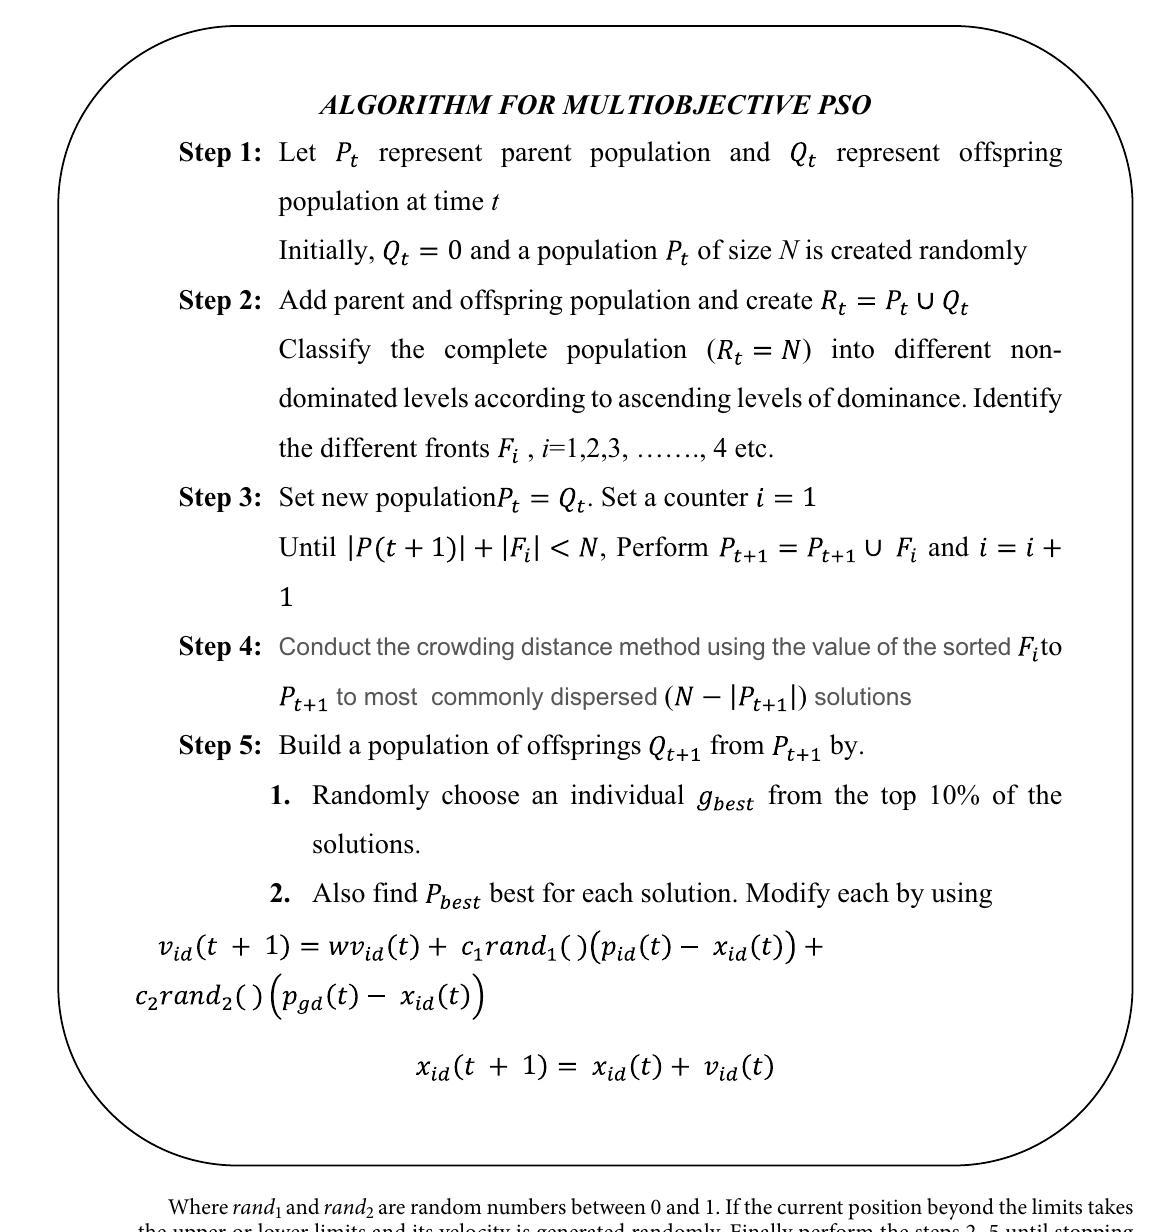
Figure 15 represents the multi-objective PSO (MOPSO) flow chart. The algorithm for MPSO is listed